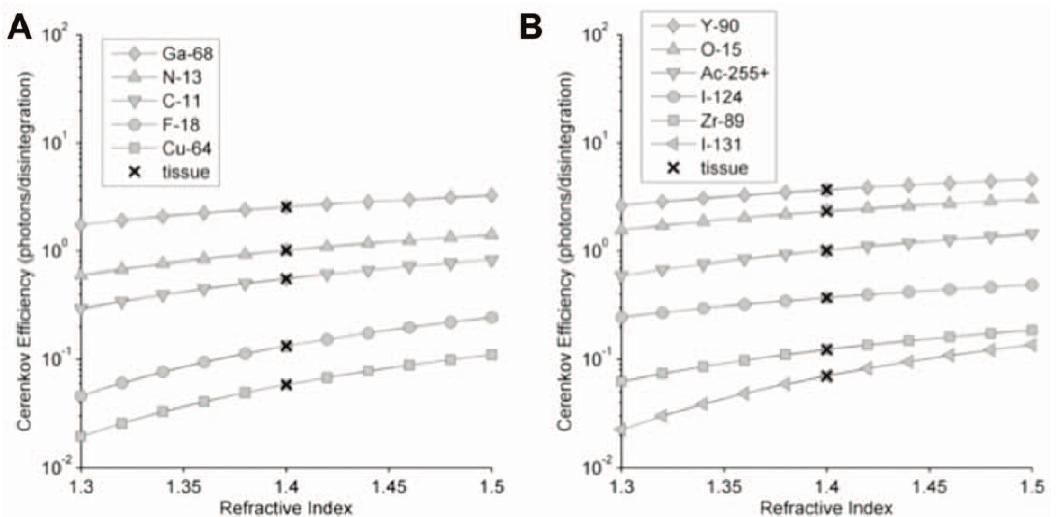
Figure 5. Modeled Cerenkov production efficiencies as a function of refractive index. Curves are the modeled efficiencies for b -particle produced CR as a function of refractive index assuming b cross-section properties and density of water. Efficiencies are in photons within the 550 to 570 nm range per disintegration. The X’s used the b cross section properties of biological tissue. (A) and (B) list different radionuclides. Note - Ac-225 + denotes Ac-225 plus its daughters in transient